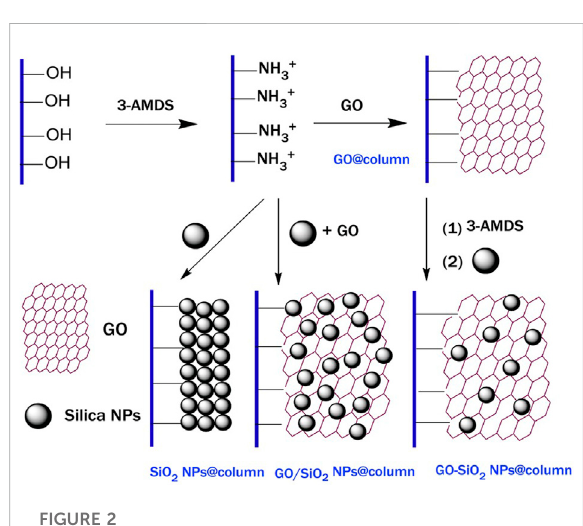
FIGURE 2 Schematic representation of the fabrication processes of the GO@column, GO/SiO 2 NPs@column, GO-SiO 2 NPs@column, and SiO 2 NPs@column. Reprinted with permission from Ref. (Qu et al., 2016). Copyright 2016